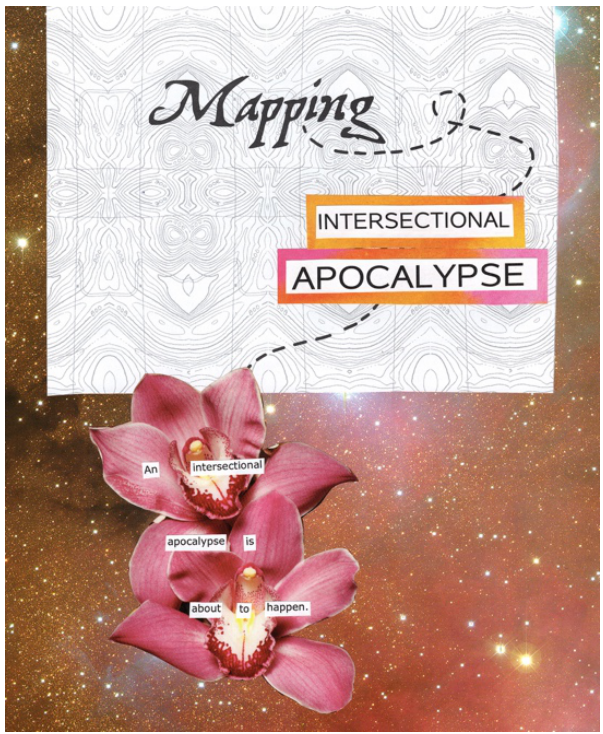
FIGURE 2: A COLLAGE CREATED BY STUDENTS (NAVI RAI, NAIYA TSANG, KAYLA UREN) FOR THE INTRODUCTION TO THE INAUGURAL ISSUE. IT READS: “MAPPING // INTERSECTIONAL APOCALYPSE // AN INTERSECTIONAL APOCALYPSE IS ABOUT TO